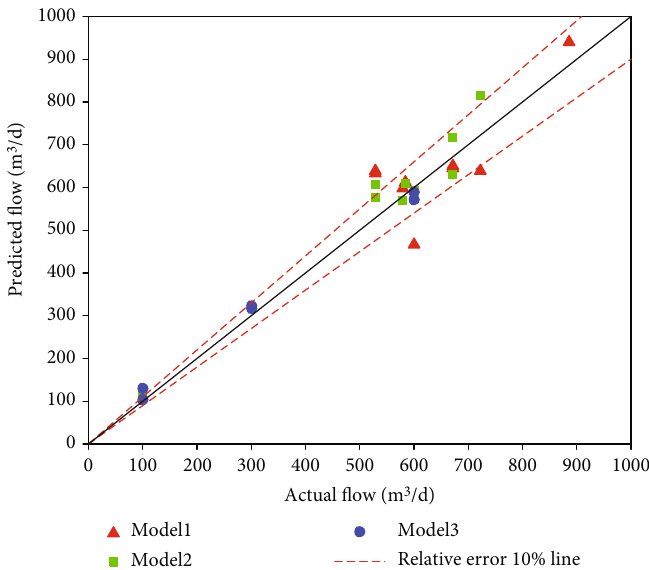
Figure 21: Comparison chart of the prediction e ff ect of the three